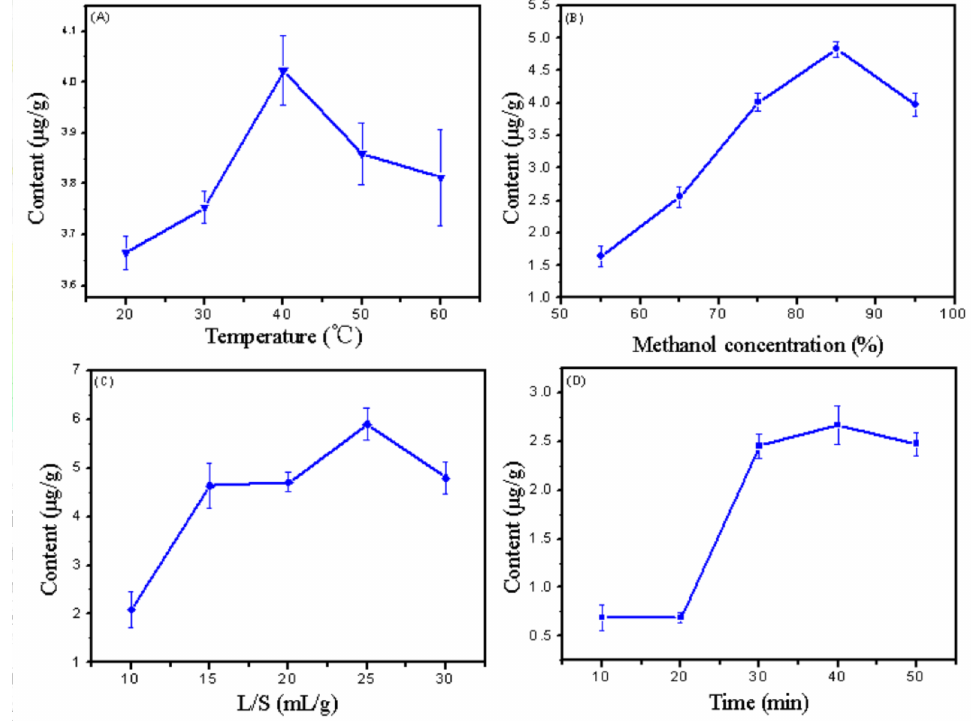
Figure 1. The effect of reaction conditions on the extraction efficiency of gigantol. ( A ) temperature; ( B ) methanol concentration; ( C ) liquid-to-solid ratio; ( D ) extraction